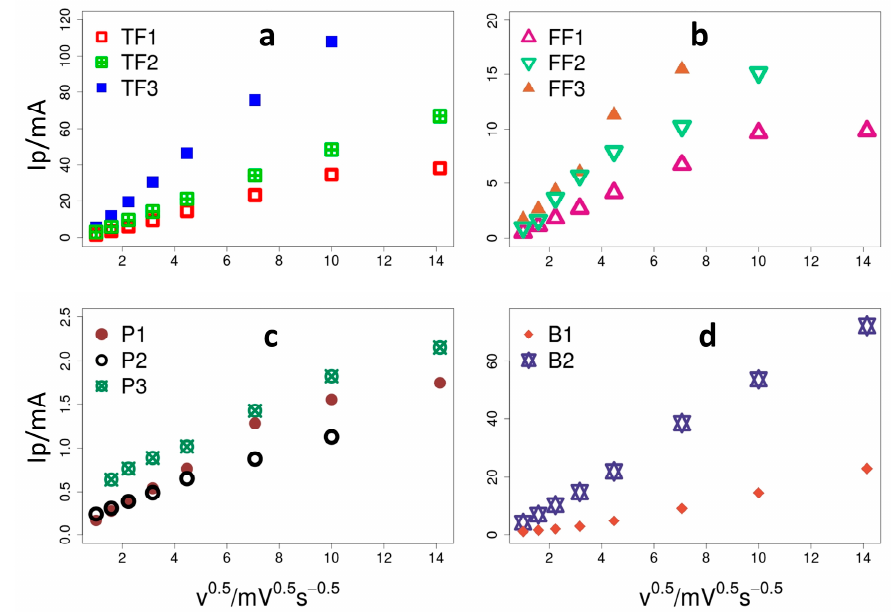
Figure 4. Randles-Šev č ik plot ( a ) thick felt (TF); ( b ) fine felt (FF); ( c ) paper (P); ( d ) brush (B).